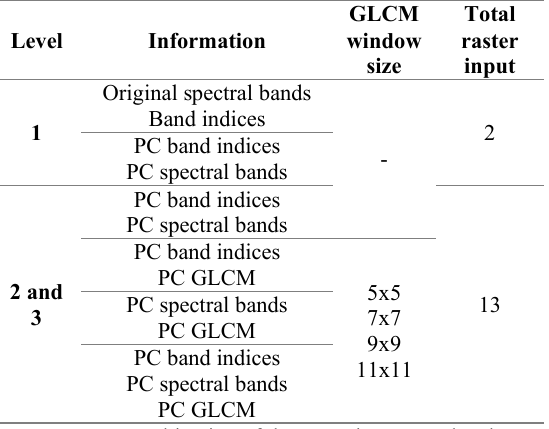
Table 5. Image combination of the raster inputs per level